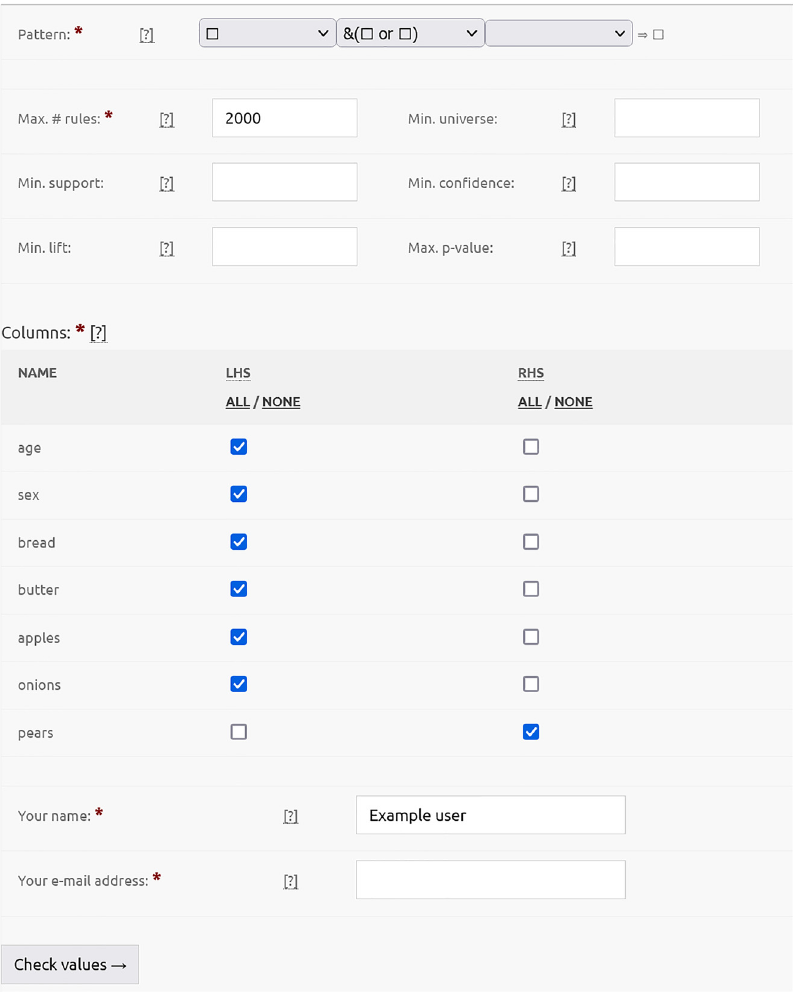
Figure 2: The parameter screen of the SCARF